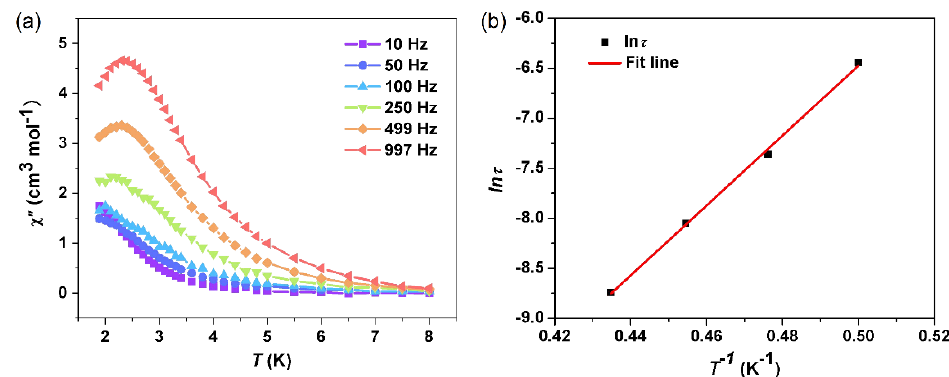
Figure 5. ( a ) Temperature dependent χ ” ac susceptibility for complex 1 ( H dc = 1500 Oe); ( b ) the ln( τ ) vs. T − 1 plots based on the Arrhenius relationship for complex 1 .